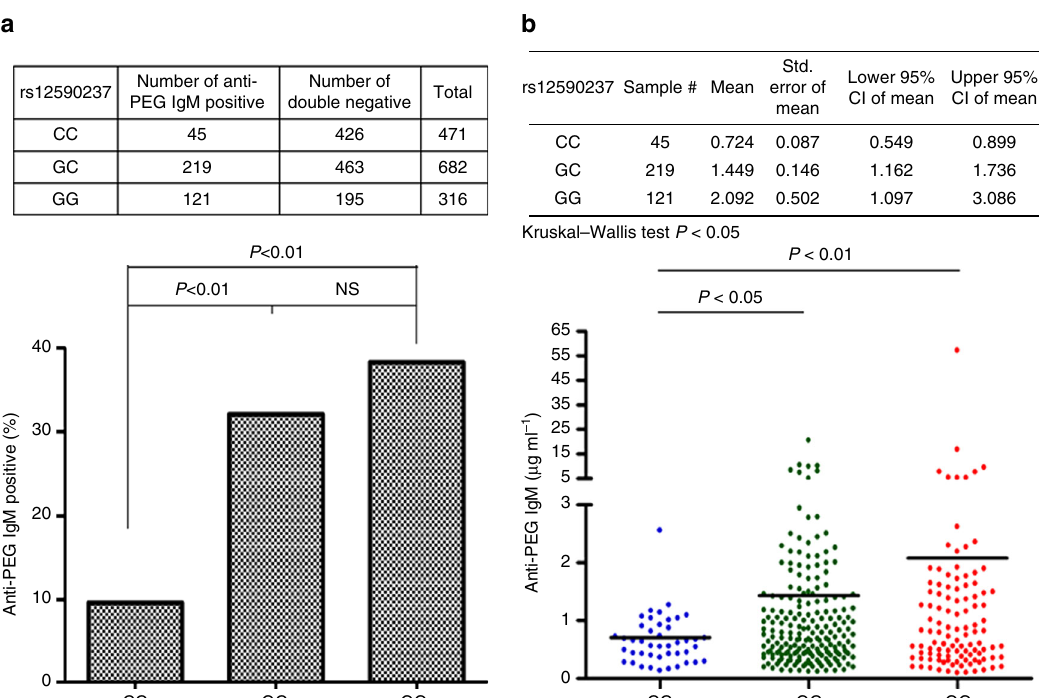
Fig. 3 Correlation between IGH polymorphism (rs12590237) and antibody response of anti-PEG IgM. a The percentage of anti-PEG IgM positive in different genotype of SNP rs12590237. Signi fi cant differences among different genotypes were calculated using the z -score test for two population proportions. b Comparison of relative concentration of anti-PEG IgM in different genotype of SNP rs12590237. The plasma levels of anti-PEG antibodies from 1985 individuals were conducted by anti-PEG ELISA assay. The relative concentration of samples with anti-PEG IgM was calculated by comparison with cAGP4-IgM standard curves. Signi fi cant differences among different genotypes were performed by using the Kruskal – Wallis